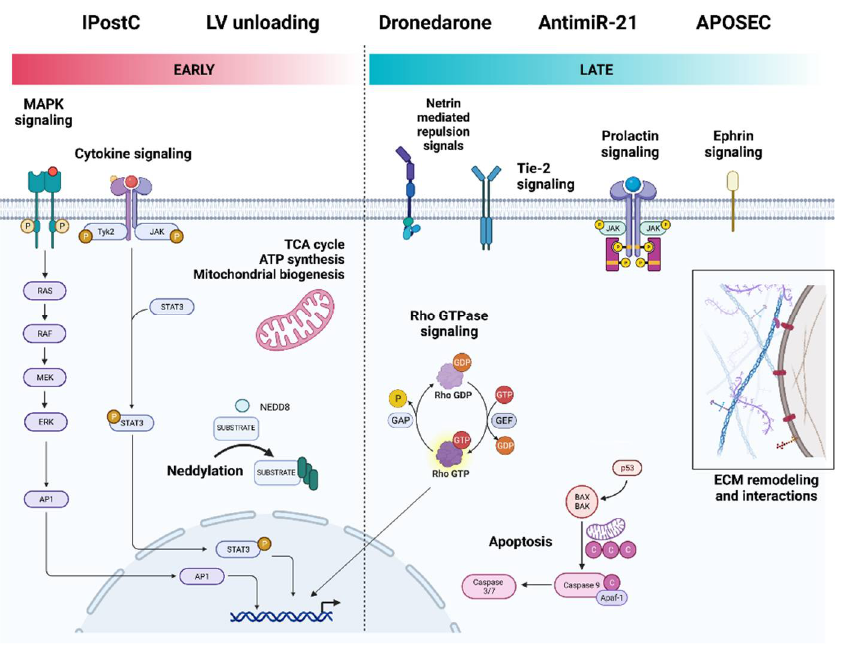
Figure 7. Cardioprotective pathways in myocardial IRI.